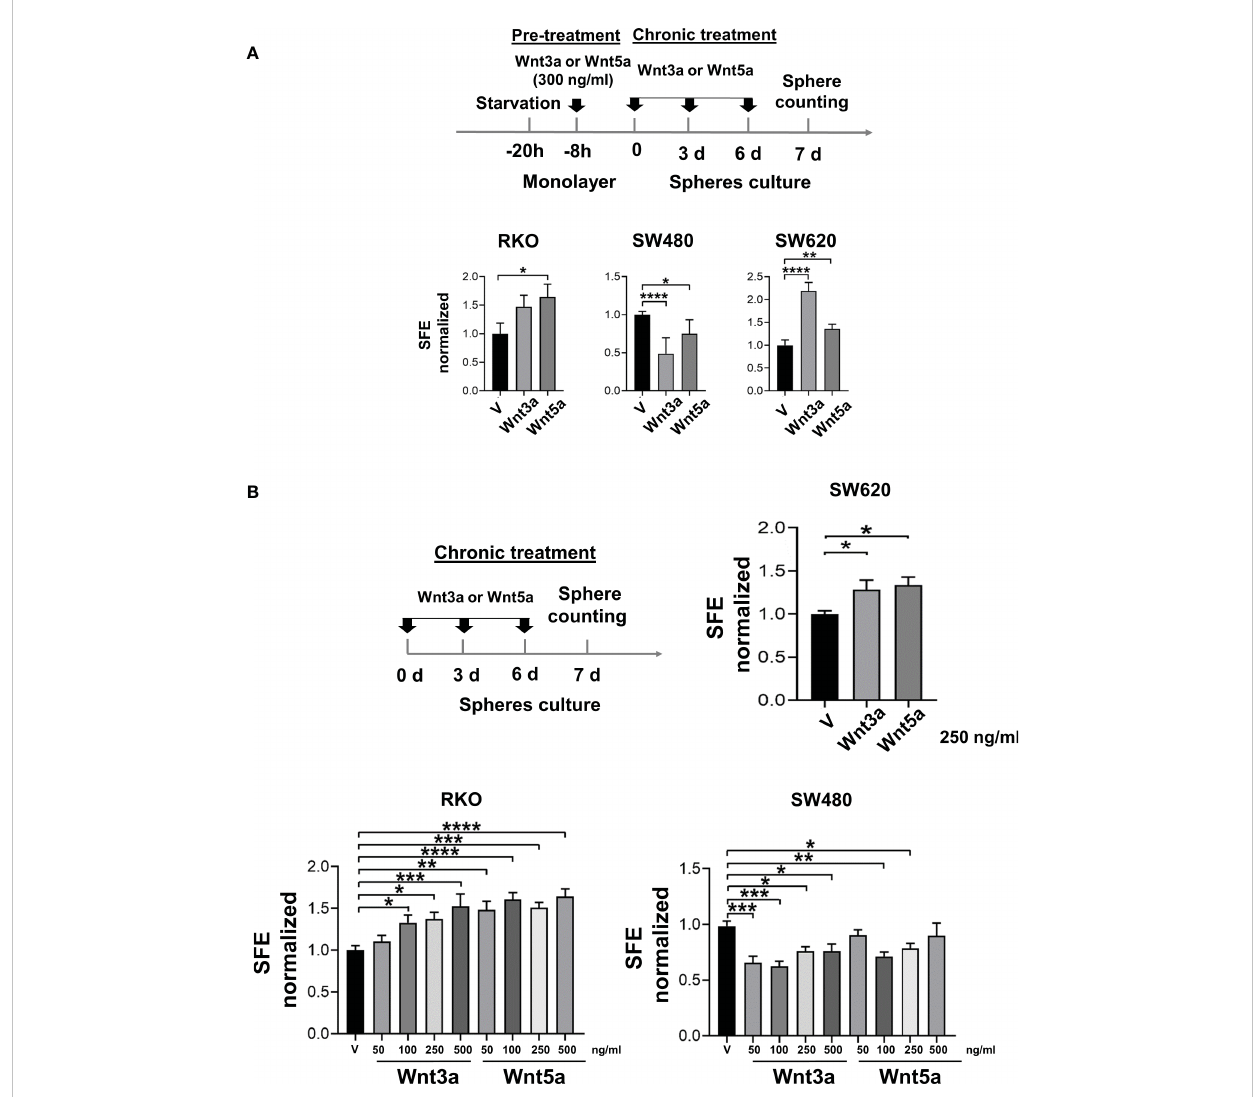
FIGURE 3 Wnt3a and Wnt5a stimulate spheres formation in RKO and SW620 but decrease in SW480. (A) Experimental scheme for spheres stimulation (upper panel) and quanti fi cation of SFE in RKO, SW480, and SW620 cells (lower panel) with pre-treatment and chronic treatment with Wnt3a or Wnt5a. (B) Experimental scheme for spheres stimulation (upper panel) and quanti fi cation of SFE in RKO, SW480, and SW620 cells (lower panel) with the chronic treatment of Wnt3a or Wnt5a at the indicated concentrations. Data are represented as the mean values ± SEM of at least three independent experiments. Statistical analysis was performed using one-way ANOVA followed by Bonferroni´s multiple comparisons. *p<0.05; **p<0.01; ***p<0.001;